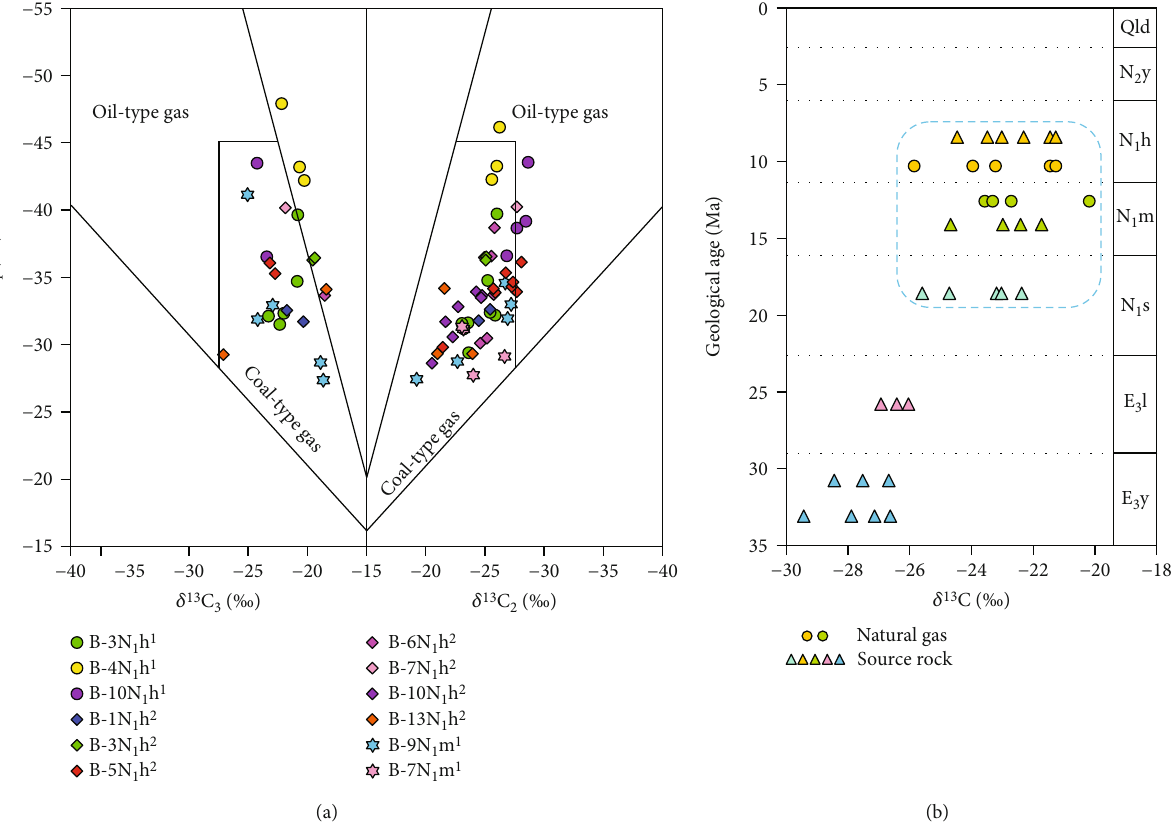
Figure 9: (a) Genetic classi fi cation of natural gas (the discrimination diagram is modi fi ed from [40]) and (b) the stable carbon isotope of the natural gas and source rocks in the LD-B Wellblock in the Yinggehai